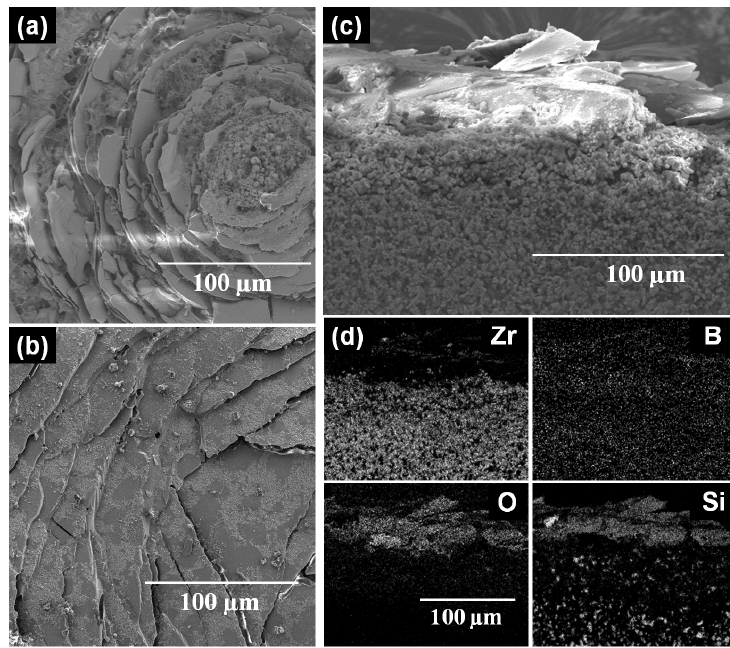
Figure 6. SEM micrographs depicting the top surface of oxide scale formed by cyclic oxidation for 24 h in air at 1300 °C on: ( a ) ZS, ( b ) ZSS and Cross ‐ section of the oxide scale formed on ZSS; ( c ) SEM (BSE) image, as well as ( d ) EDS maps of Zr, B, O, and Si.